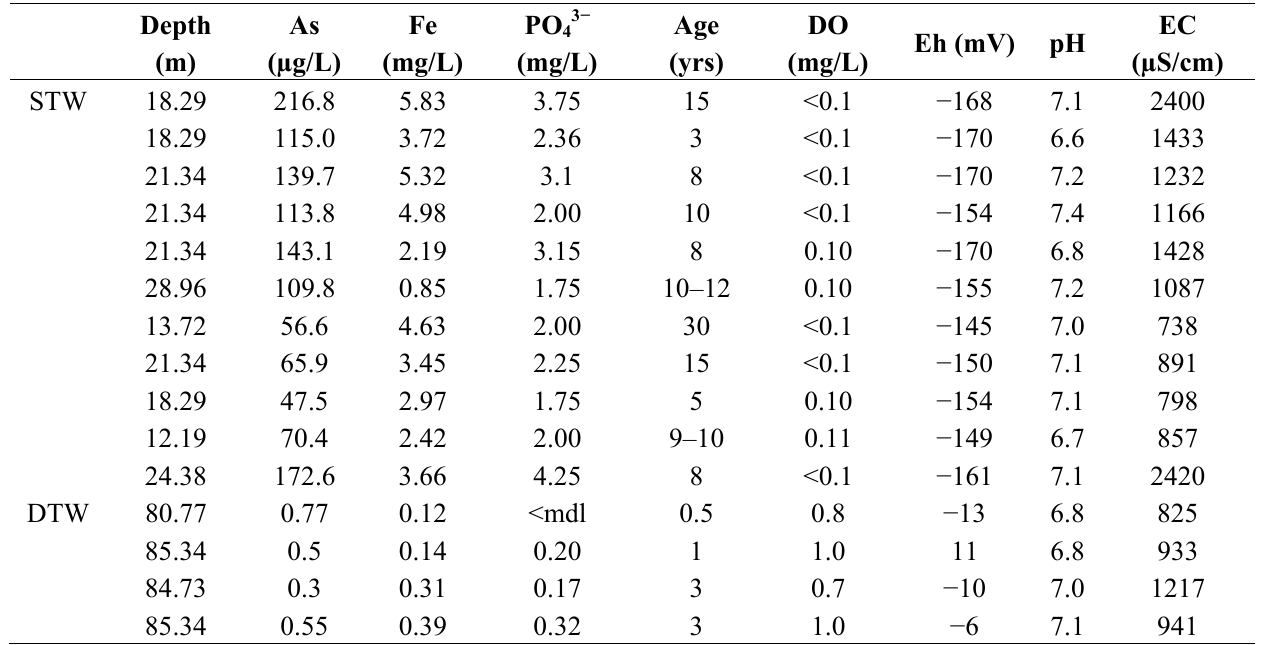
Table 1. Concentrations of different chemical species in groundwater and surface water from